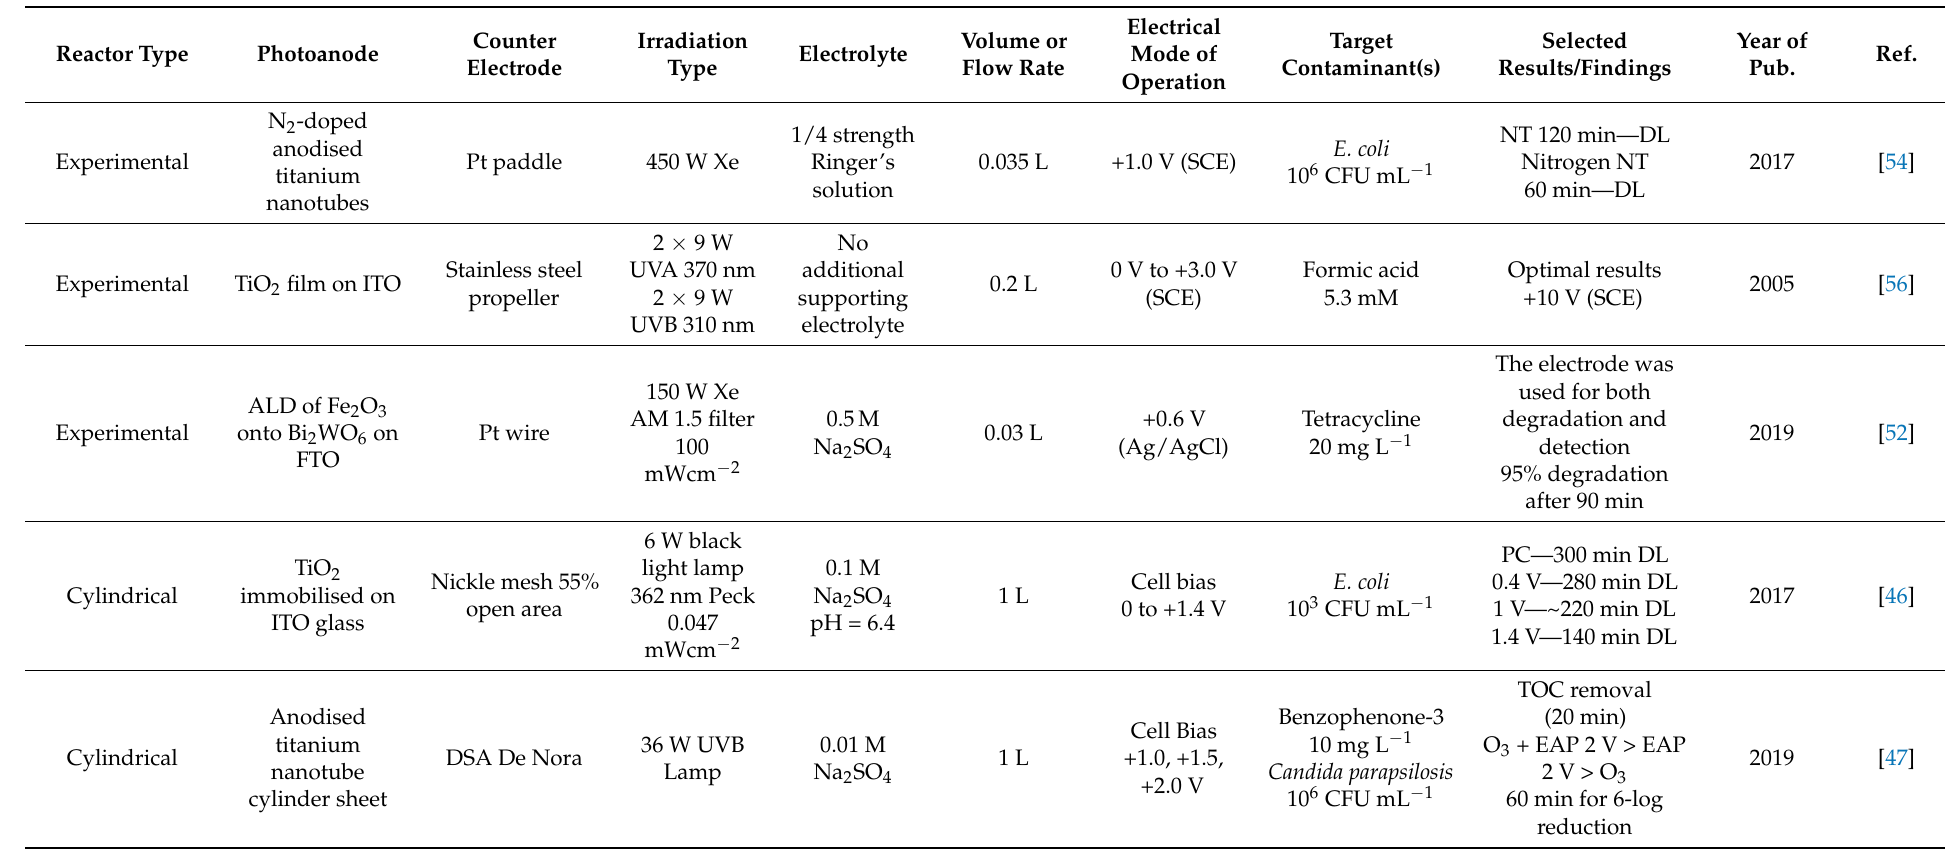
Table A1. Selection of PEC reactors, their operational parameters, and selected results. DL—detection limit, % amount of